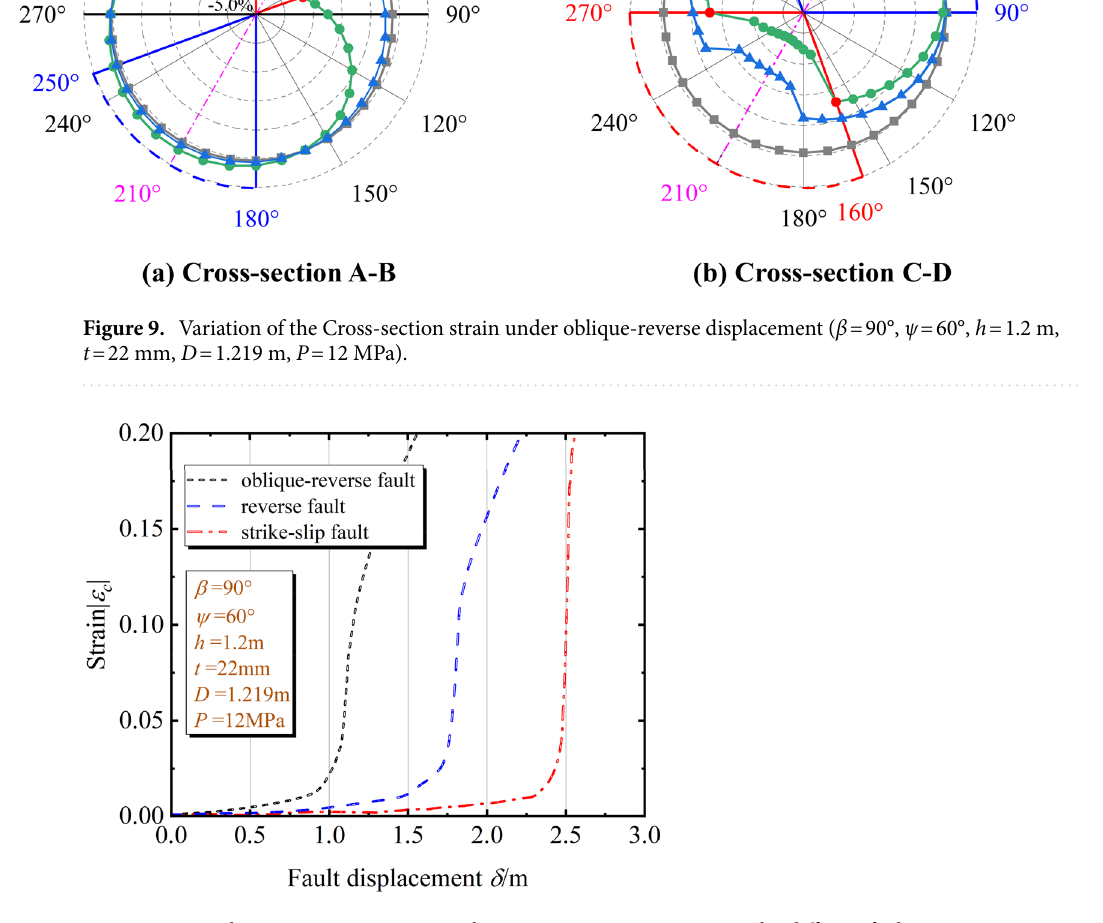
Figure 10. Pipeline compressive strain on the maximum strain position under different fault